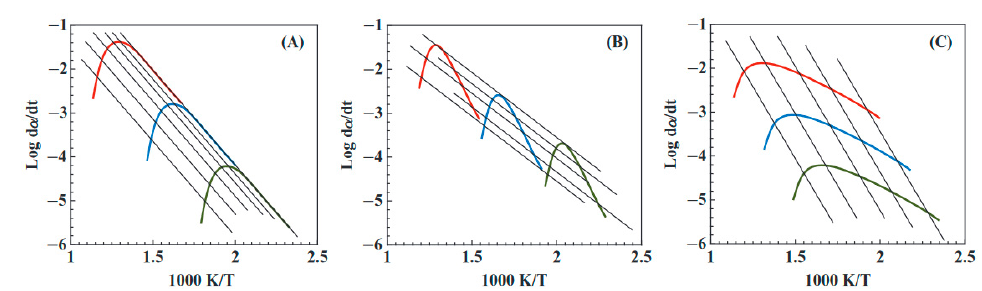
Figure 2. Friedman plots corresponding to a normal type of reaction ( A ), an accelerated reaction ( B ), and a retarded reaction ( C ). The red, blue, and green lines represent 3 di ff erent constant heating rates with red being the highest and green the lowest.